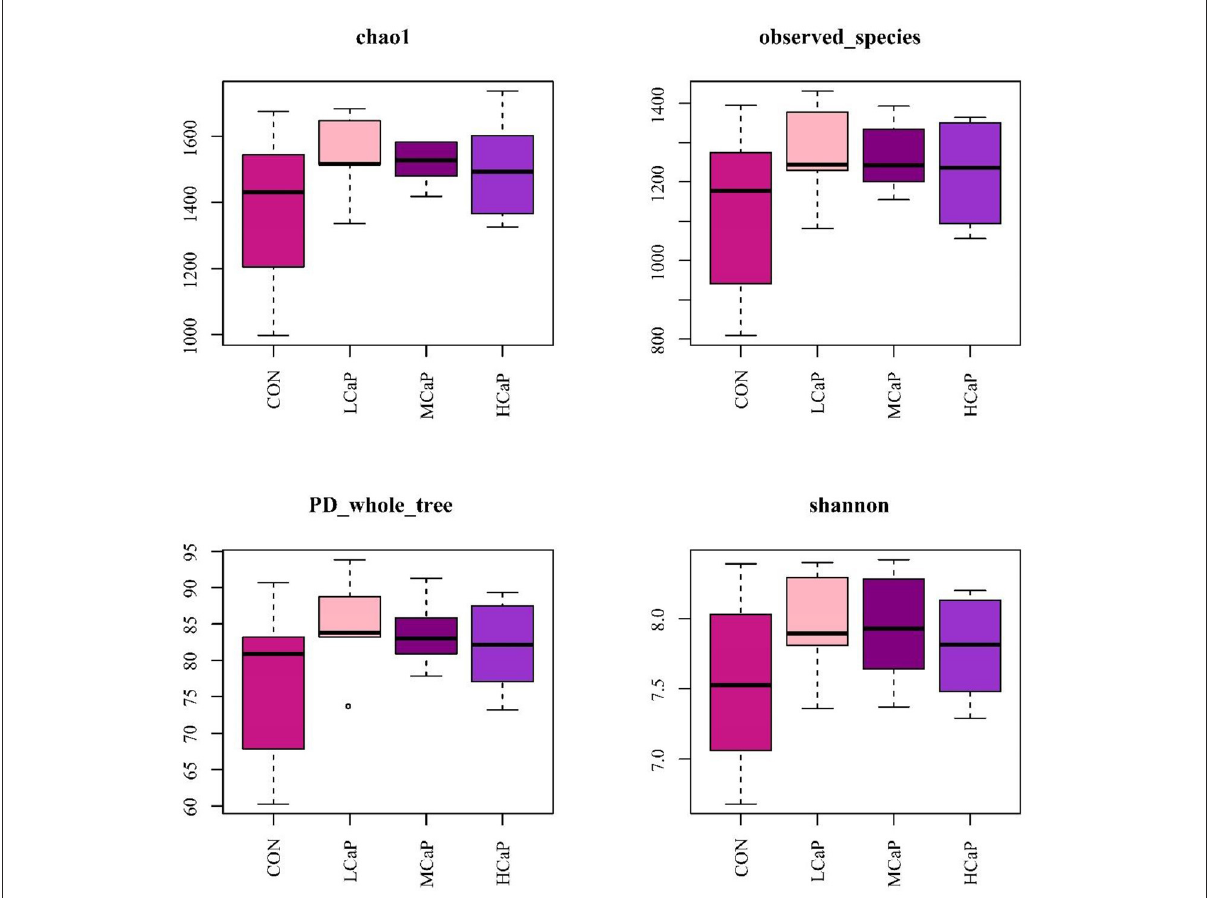
FIGURE2 Box-and-whisker plots of alpha diversity indices in the fecal bacterial communities in different levels of calcium propionate treatments. CON, control group; LCaP, low calcium propionate group, basal diet + 200 g/d calcium propionate; MCaP, medium calcium propionate group, basal diet + 350 g/d calcium propionate; HCaP, high calcium propionate group, basal diet + 500 g/d calcium